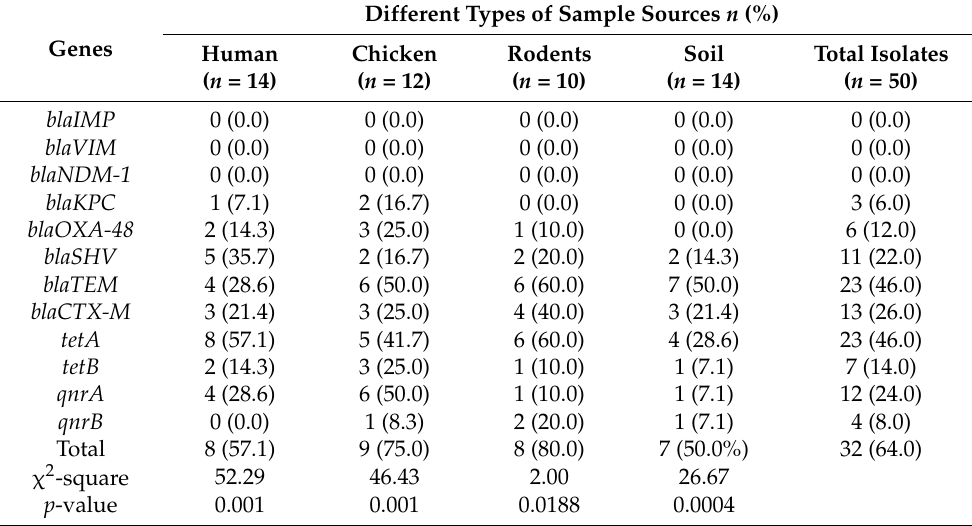
Figure 1. Occurrence of resistance genes in MDR E. coli isolates from different sample types. Table 2. Prevalence of antimicrobial resistance genes in MDR E. coli isolates from different sample